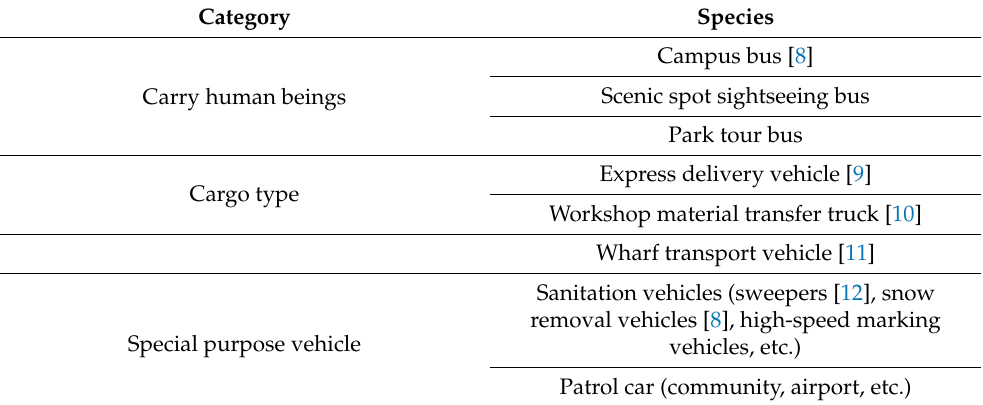
Table 1. Types of low-speed small unmanned